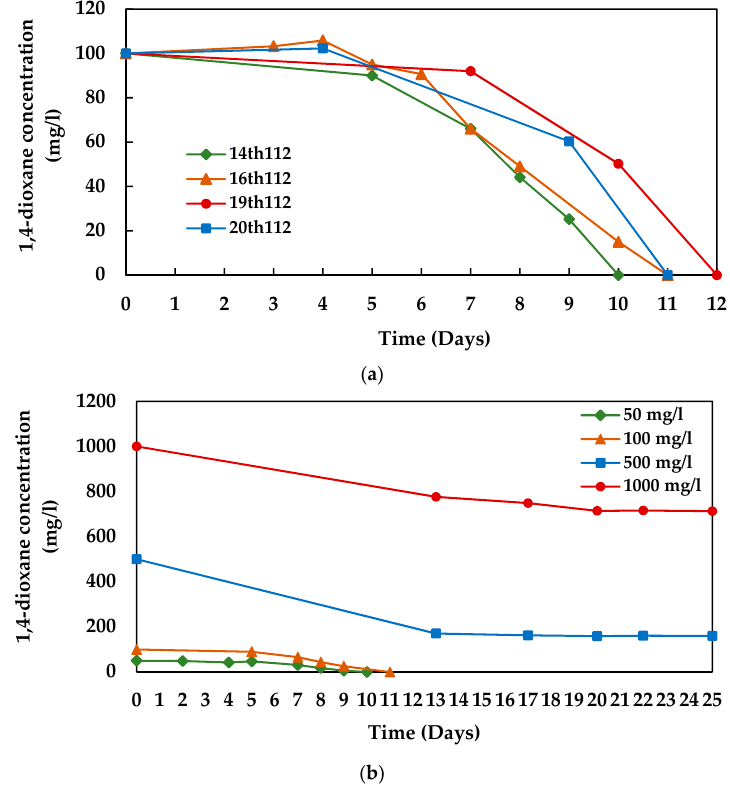
Figure 1. 1,4-dioxane degradation profile of the consortium 112, ( a ) by different generations and ( b ) at different initial 1,4-dioxane concentrations (by 14th generation).